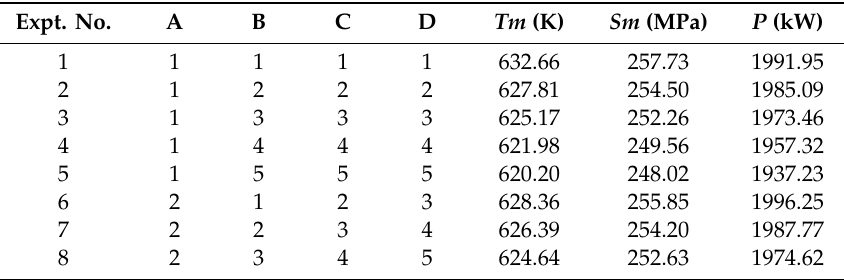
Table 8. Taguchi’s orthogonal table and optimisation